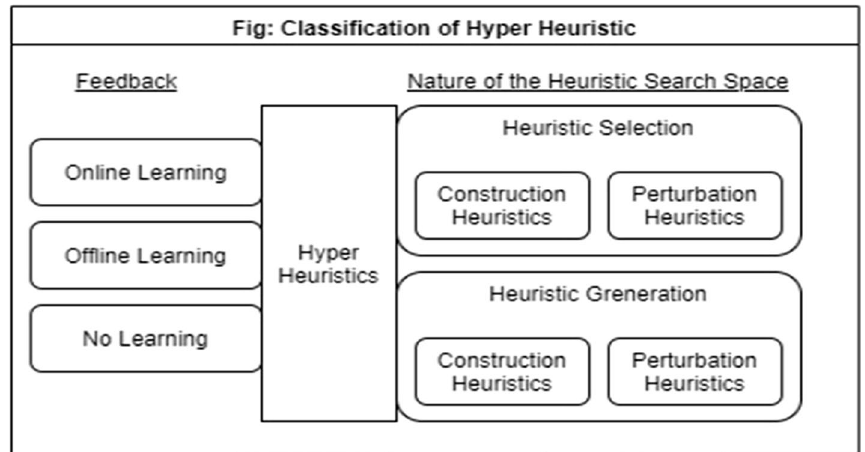
Fig. 2 Hyper-heuristic classification based on feedback and heuristic search